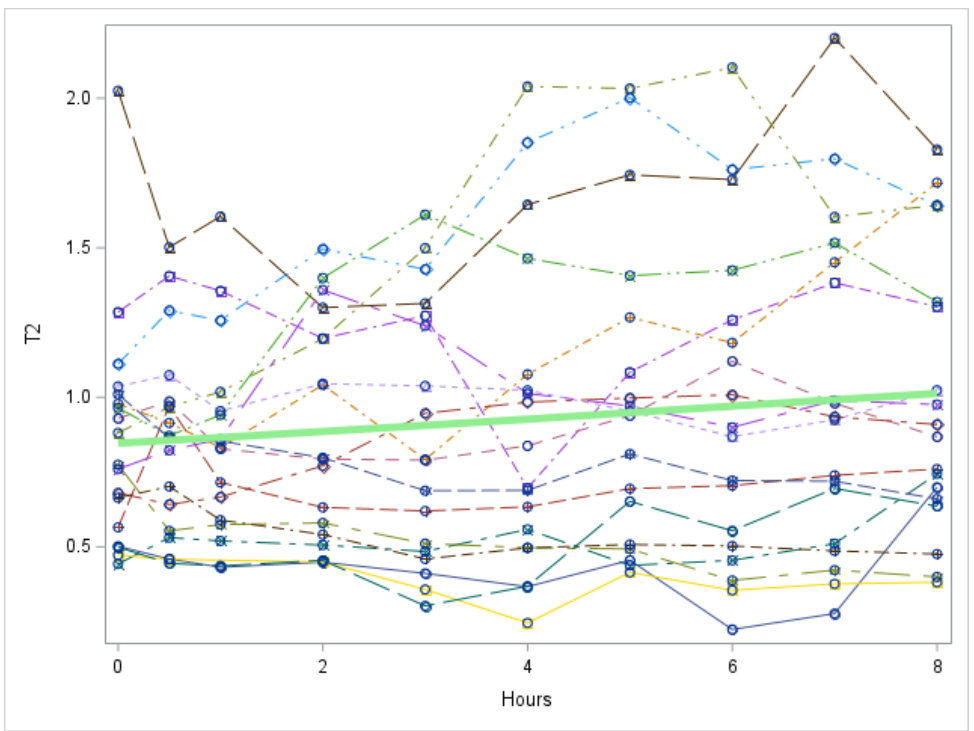
Figure A7. Study 2: 3-T1AM trend over time after last LT3 dose of the study (Each individual line represents a patient. The green line represents the mean values for all patients) . 3-T1AM = 3-T1AM concentration in nmol/L . There is no significant trend in 3-T1AM over time, p value = 0.4177.